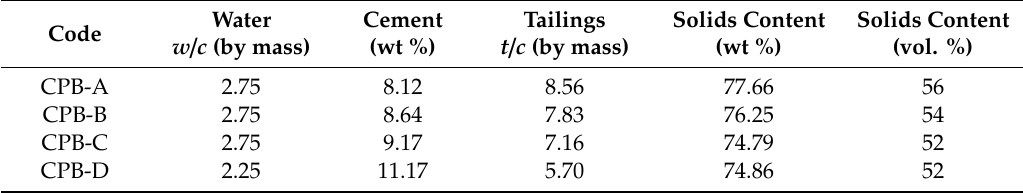
Table 3. Mixture proportions of